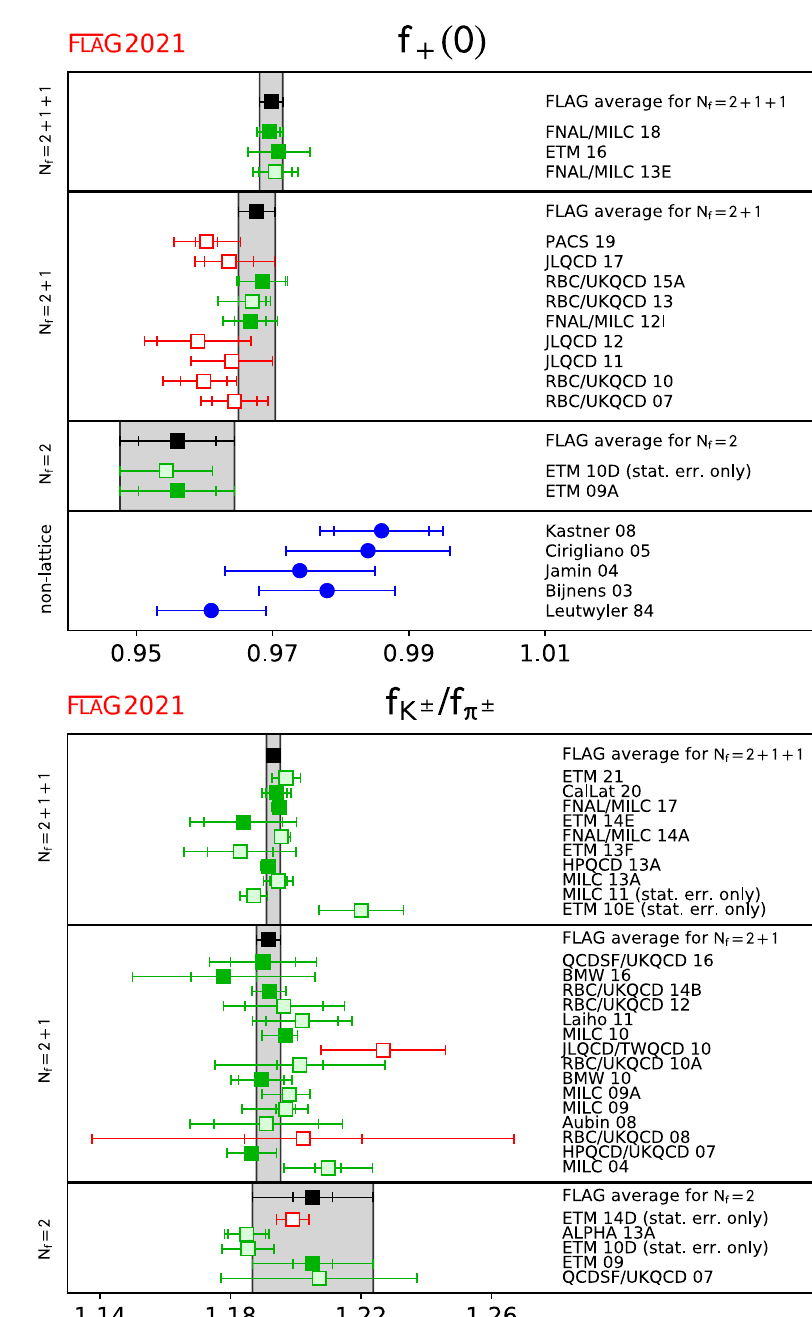
Fig. 9 Comparison of lattice results for f K ± / f π ± . This ratio is obtained in pure QCD including the SU ( 2 ) isospin-breaking correction (see Sect. 4.3). The black squares and grey bands indicate our averages in Eqs.